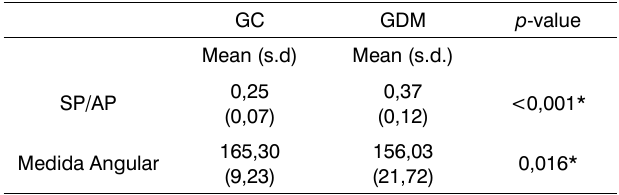
Table 3. Standard Deviation and p -value for comparing the means for the SP/AP ratio values and angular measures of GC and